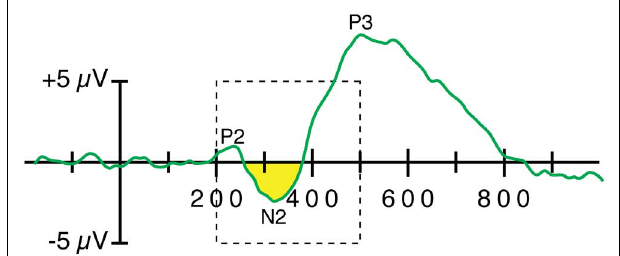
FIGURE 6 |Application of a negative area algorithm to quantify the amplitude of the N2 wave in a single-subject oddball-minus-frequent difference wave. In this example, the algorithm finds the area of the region that falls below the baseline within a window of 200–500 ms (indicated by the dashed rectangle).The specific time window has very little impact on the measured value, and this algorithm minimizes cancelation of the negative voltage of the N2 wave by the positive voltage of the P2 and P3